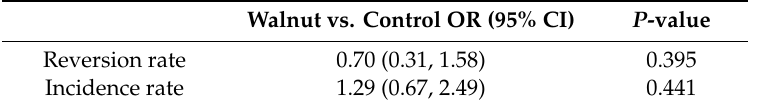
Table 5. The odds ratio for reversion and development of MetS (walnut vs.